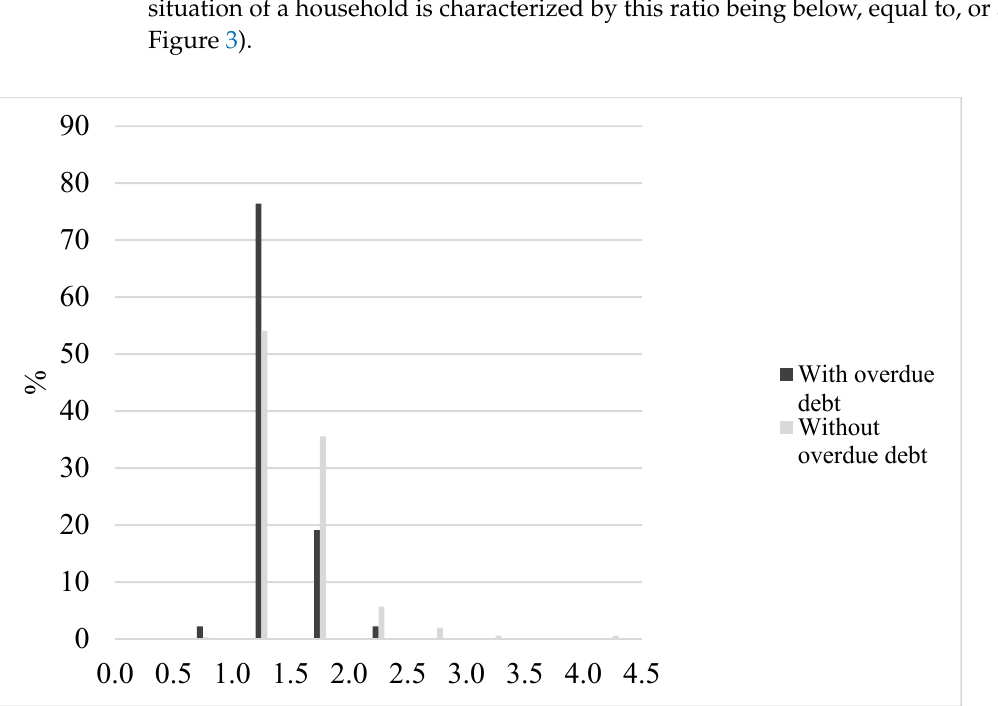
Figure 3 . Distributions of the ability-to-pay ratio in the subsamples of households with and without overdue debts. Source: Questionnaire-based survey, small settlements of BAZ County, Hungary, 2019.